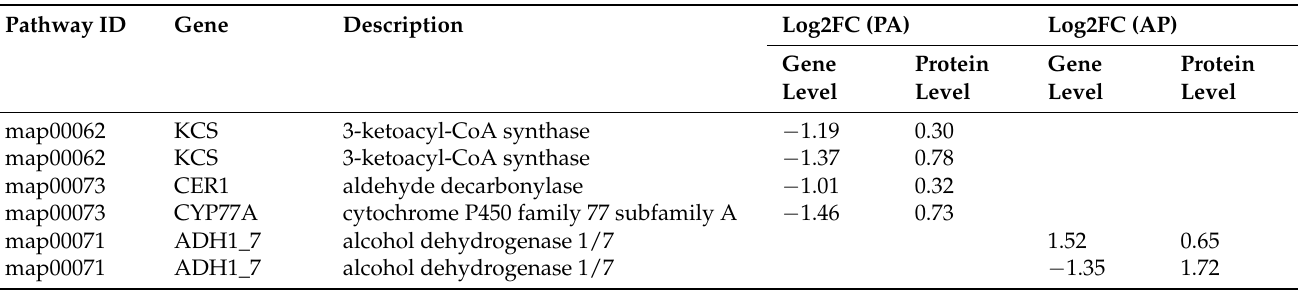
Table 1. Fold change related to the lipid metabolism DEGs/DEPs in peach/apricot (PA) and apri- cot/peach (AP).